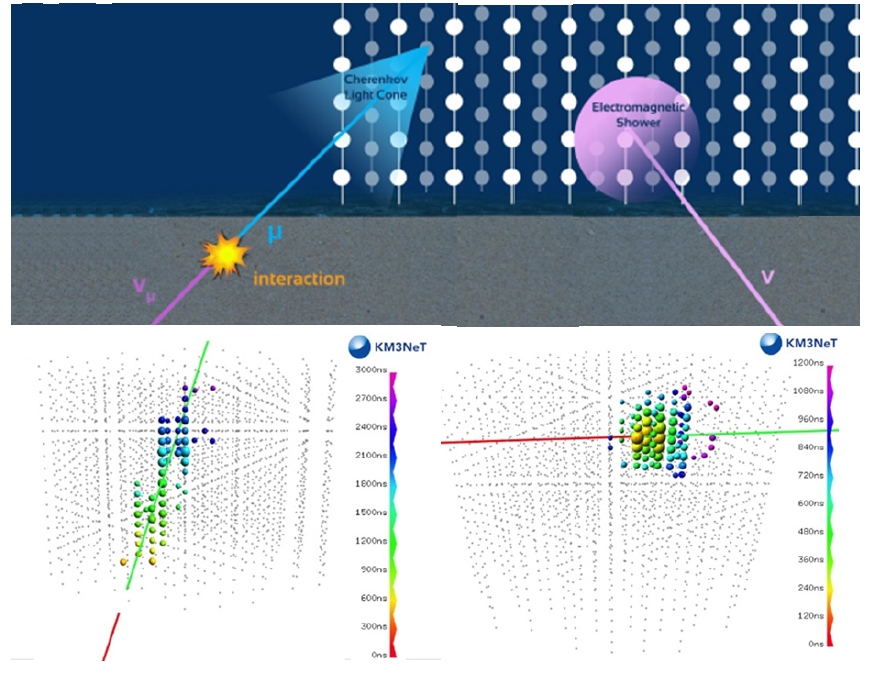
Figure 5. Neutrino interactions give two different types of events: ν µ charged current (CC) interaction that produces a muon (left) and ν e CC interaction that produces an electron inducing an electromagnetic cascade (shower). Neutral current (NC) interactions also produce showers. In this sketch, provided by the KM3NeT Collaboration, each point represents an optical module (OM), spaced about 100 m from each other. In gray are the OMs not interested by optical photons (mainly from the Cherenkov effect) produced by the event. The colors show the temporal sequence of the hit OMs—the red color indicates the beginning of the